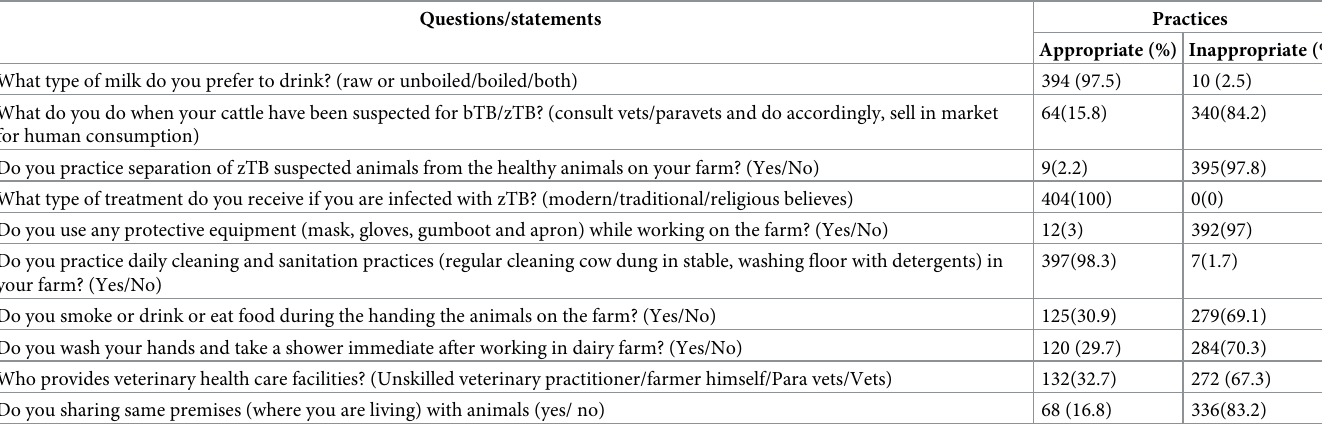
Table 5. Summary responses on cattle handlers’ practices with respect to zoonotic tuberculosis in the selected districts of Bangladesh (N = 404).